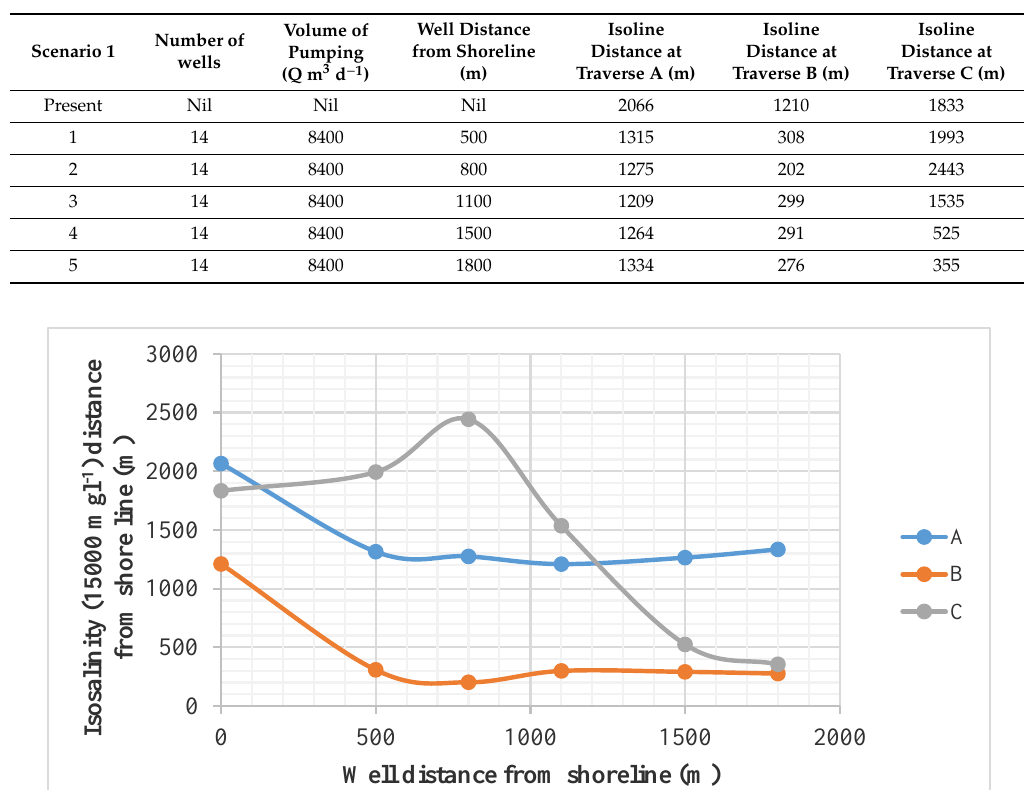
Figure 9. Location of 15,000 mgl − 1 isosalinity contour line along A, B and C after 4018 days of simulation.